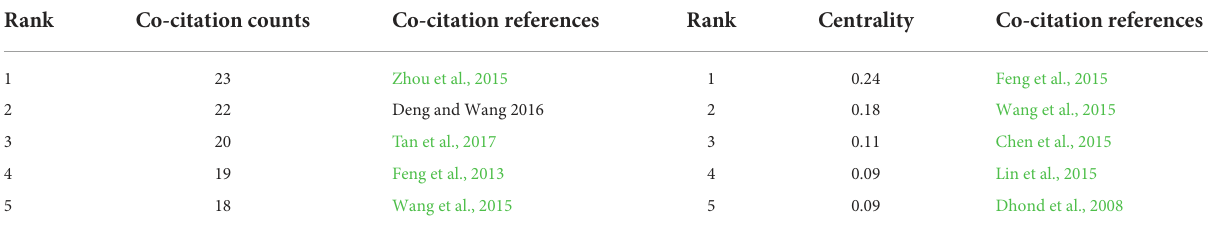
TABLE 4 Top five publications for co-citation and